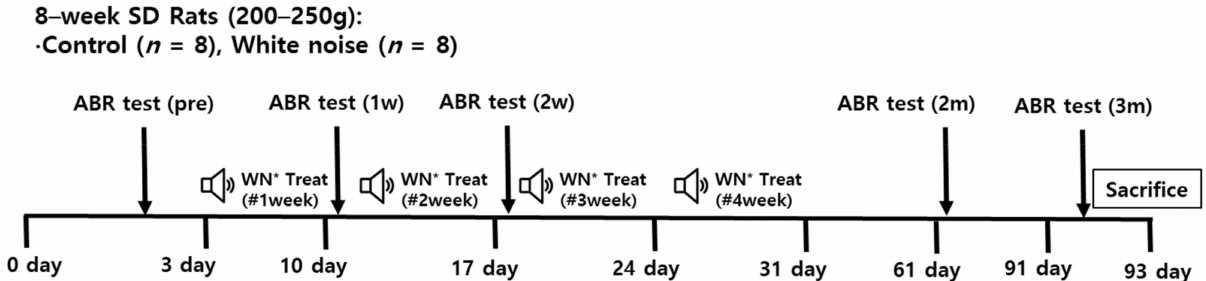
Figure 1. Design of the present study ( n = 8 per group). Noise was experienced by the rats for 4 weeks, and hearing levels were measured via auditory brainstem response (ABR) tests. The qRT-PCR of miRNA ( n = 8), the predicted target genes ( n = 8 per group), and Western blotting ( n = 6) were conducted using cochlear nuclei of the noise-exposed and control rats. * White noise (115 dB SPL) 3 h/day 3 times a